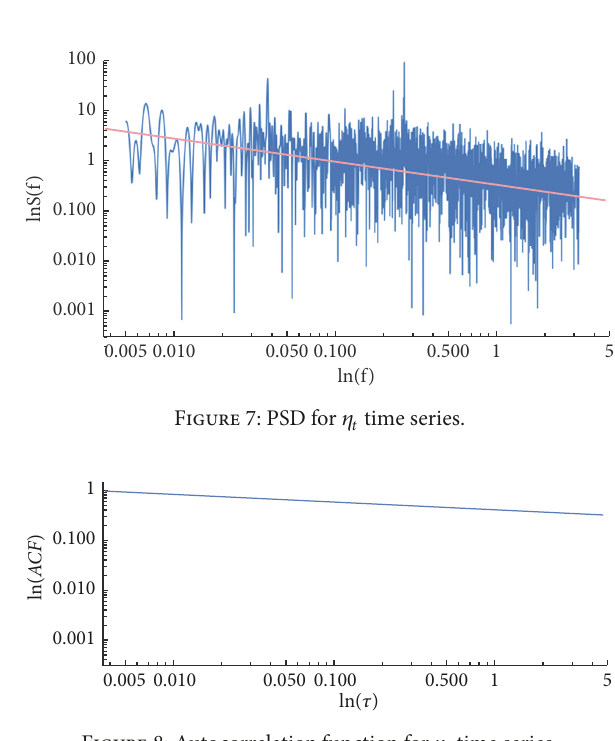
Figure 8: Autocorrelation function for 𝜂 𝑡 time